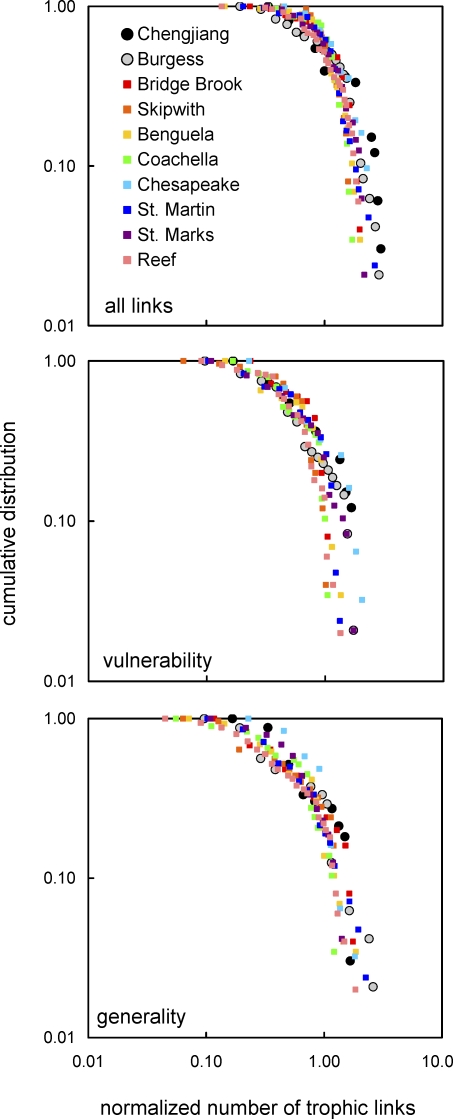
Cumulative Link Distributions for Cambrian and Modern Food WebsThe data are presented in log-log format. Cambrian web data are shown with black (Chengjiang) and gray (Burgess) circles; the data for eight modern webs are shown with smaller colored squares. The link data are normalized (divided) by the average number of links per species in each web (i.e., 2L/S).